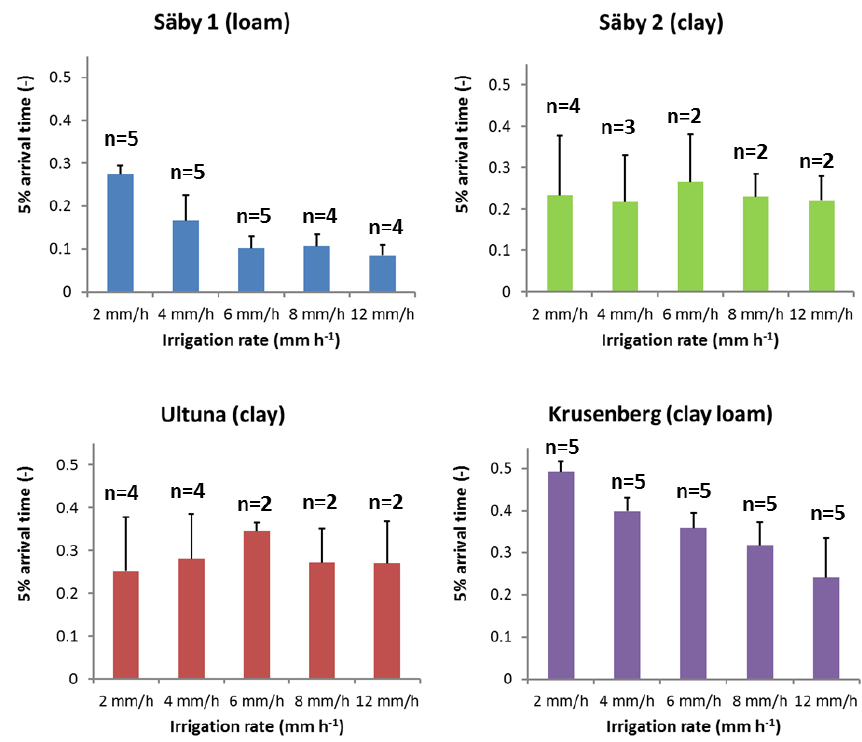
Figure 7. Mean 5% arrival times for the four soils. The number of breakthrough curves, n , was smaller at higher irrigation rates due to ponding. Error bars indicate 1 standard